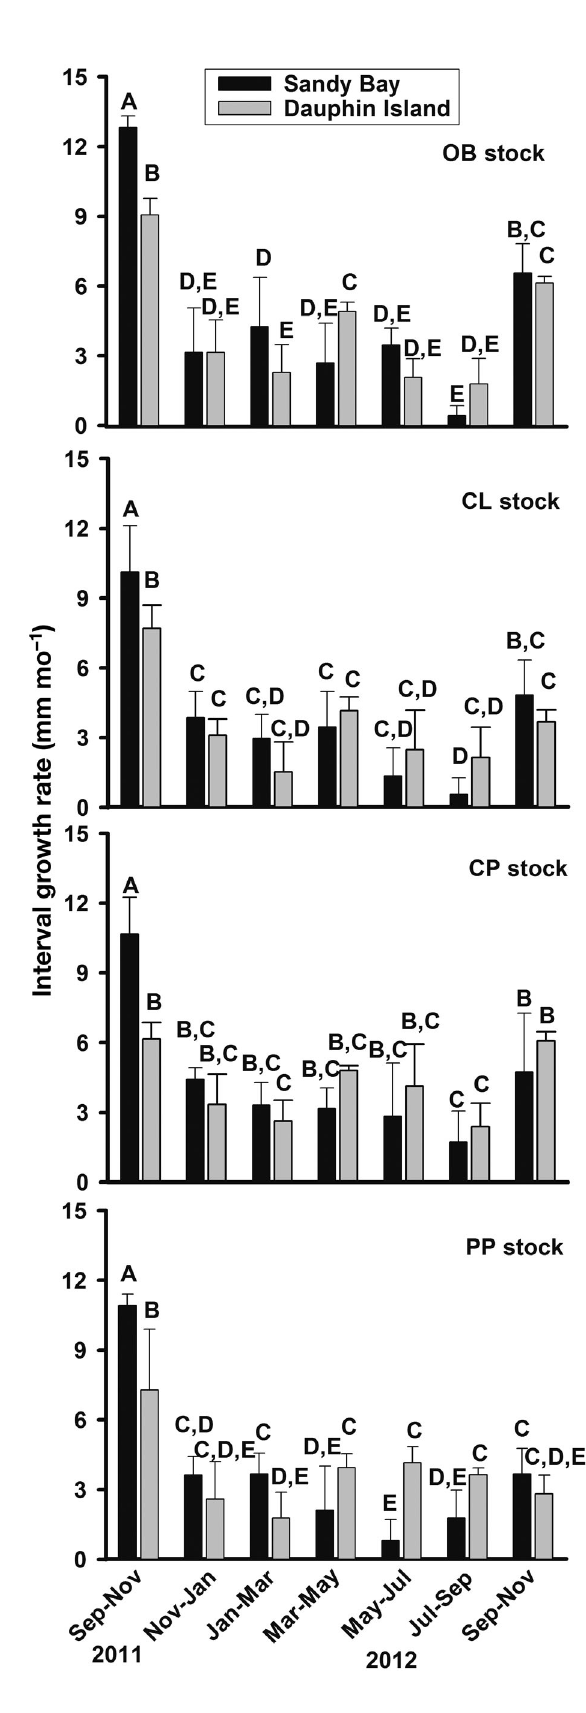
Fig. 7. Mean (±SD) interval growth rates of Louisiana east- ern oysters from the OBOY (OB) and Calcasieu Lake (CL) stocks, and Alabama oysters from the Cedar Point (CP) and Perdido Pass (PP) stocks at the Sandy Bay and Dauphin Island study sites. Interval growth rate of each stock was sig- nificantly affected by the interaction of site and sampling interval. Groups that do not share letters have means that are significantly different (p <